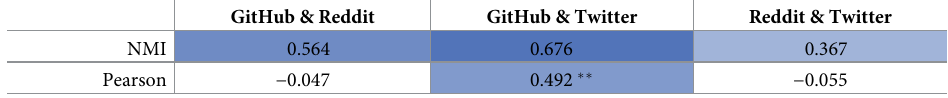
Table 2. Daily CVE discussion volume correlations across social platforms measured as Pearson correlation and NMI between GitHub events, Reddit comments, and tweets ( �� significant at p <